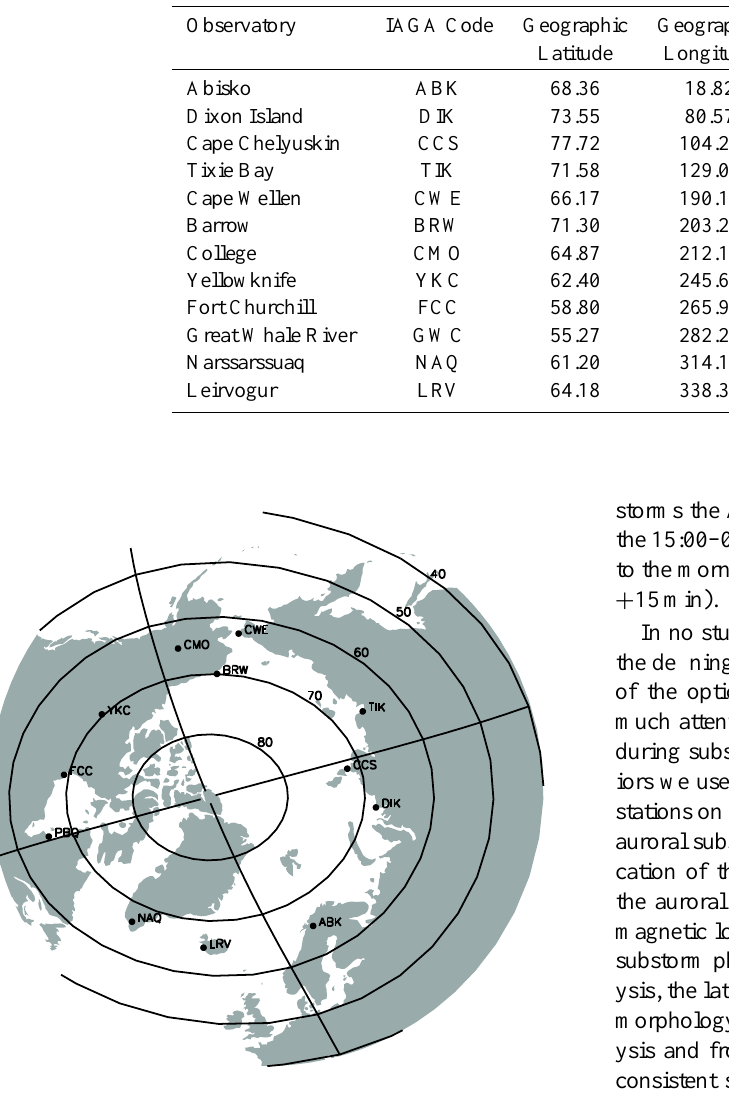
Fig. 1. Spatial distribution of AE-stations with corrected geomag- netic coordinates and